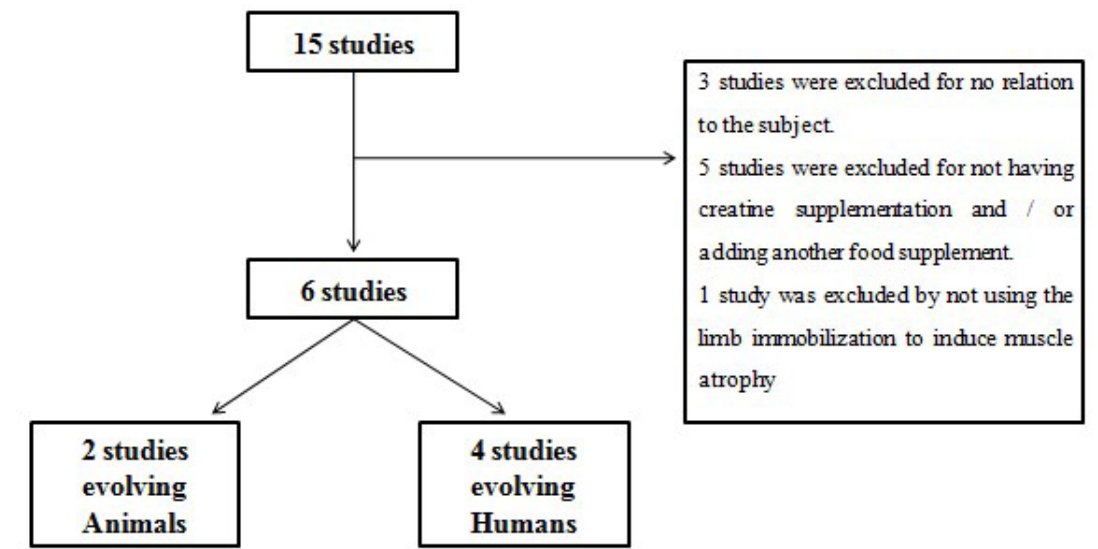
Figure 1 - Procedures for inclusion of studies in this systematic